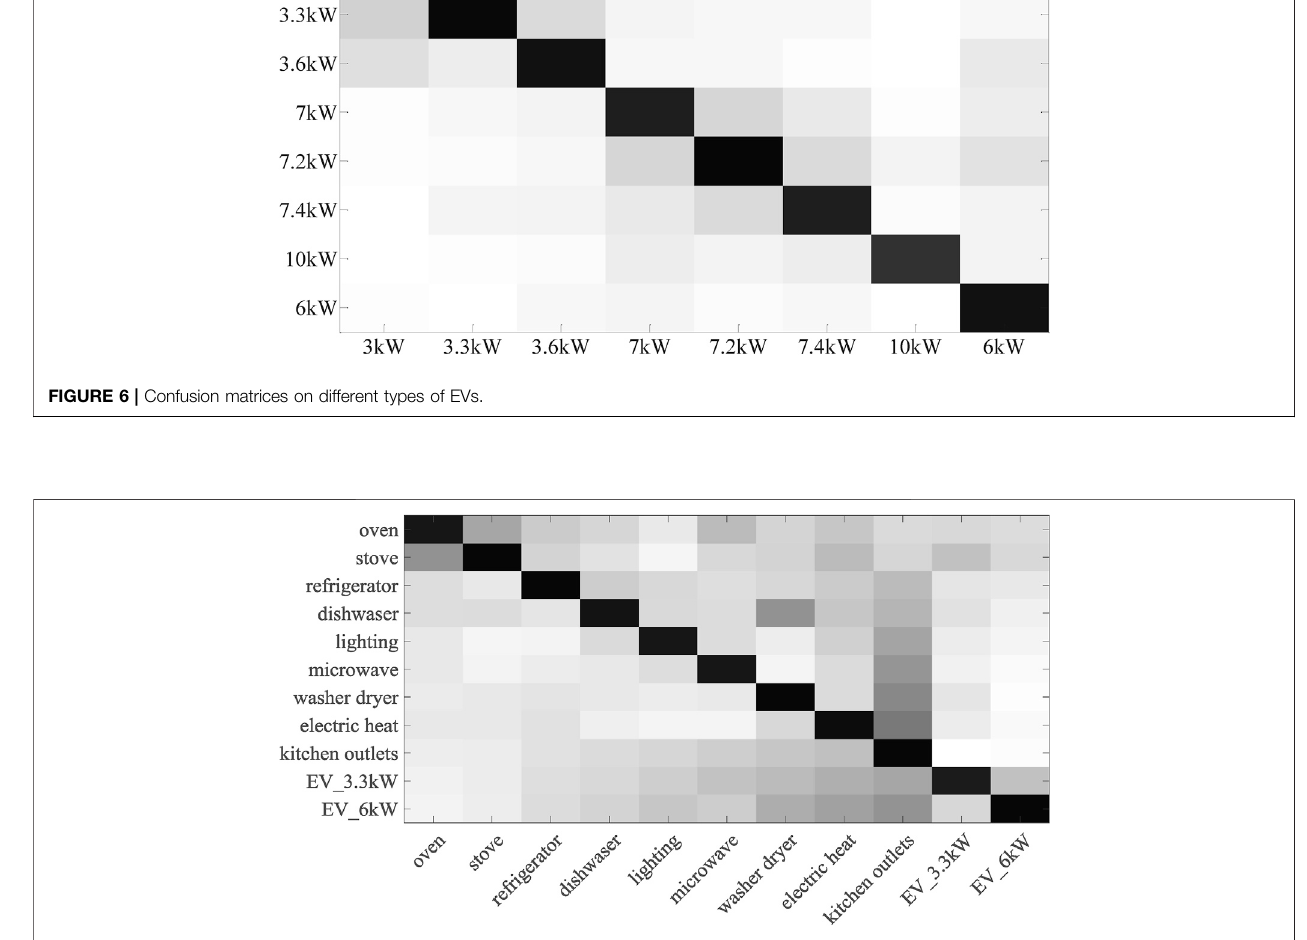
FIGURE 7 | Confusion matrices on different appliances.